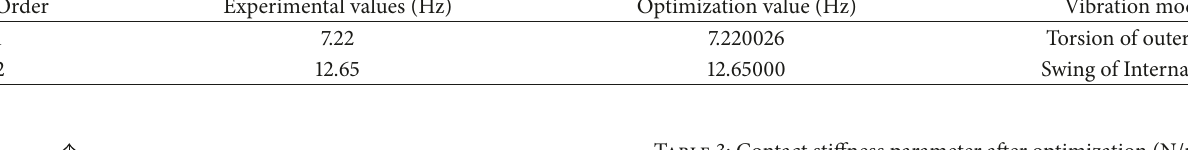
Table 3: Contact stiffness parameter after optimization